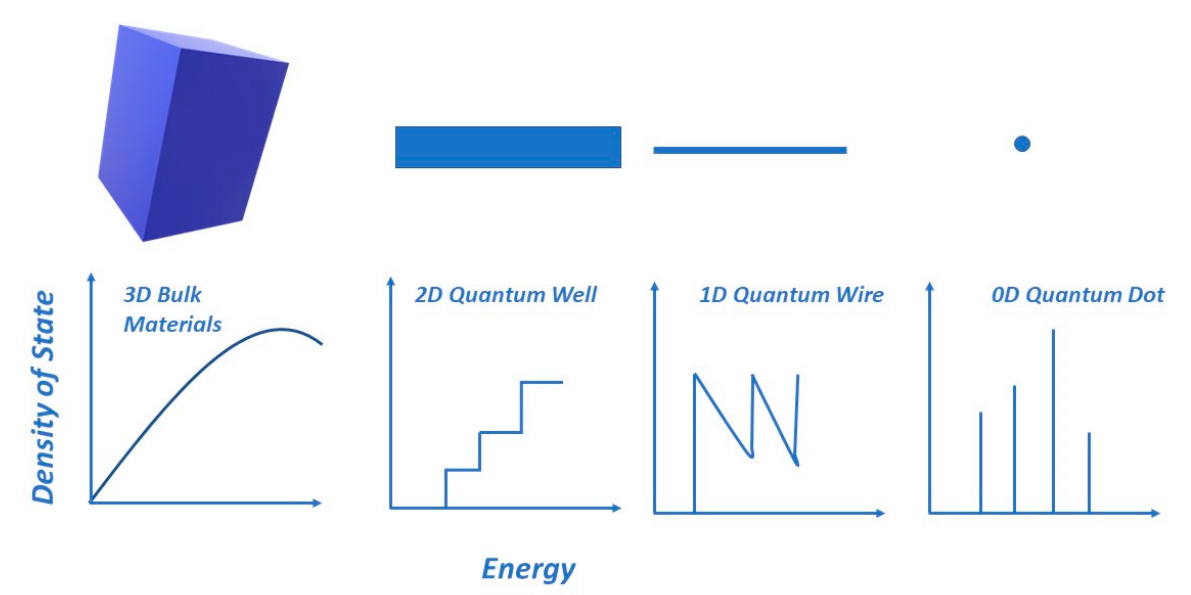
Figure 1. Schematic of nanomaterials based on